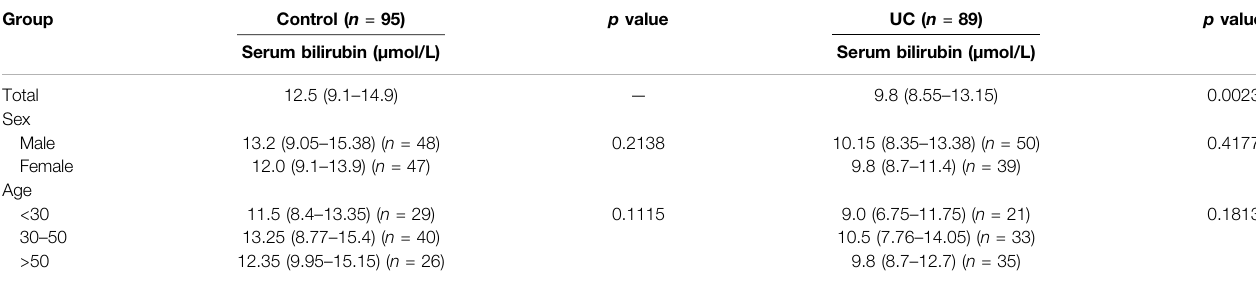
TABLE 1 | Total serum bilirubin levels are reduced in IBD patients.